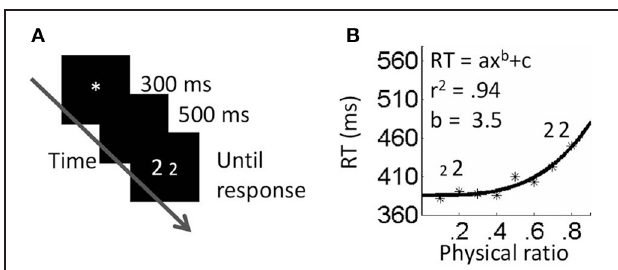
FIGURE 2 | Neutral physical task. (A) Procedure. (B) Results. Fitting the data to a power function resulted in higher fits than fitting to a linear